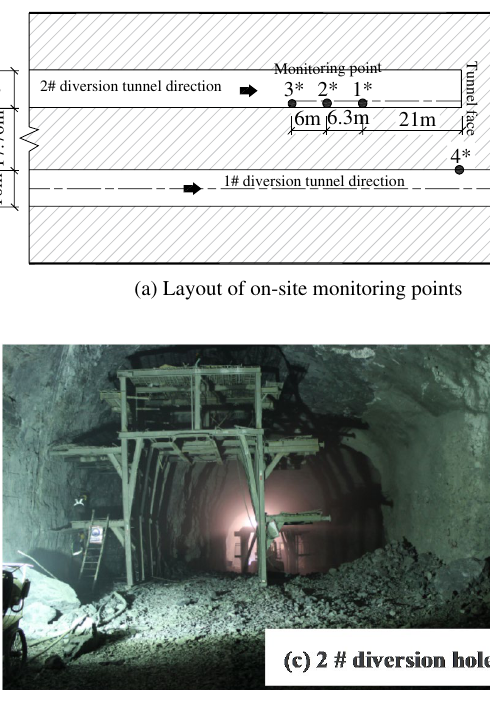
Figure 16. Blasting vibration test of diversion tunnel group of Fubugou Hydropower